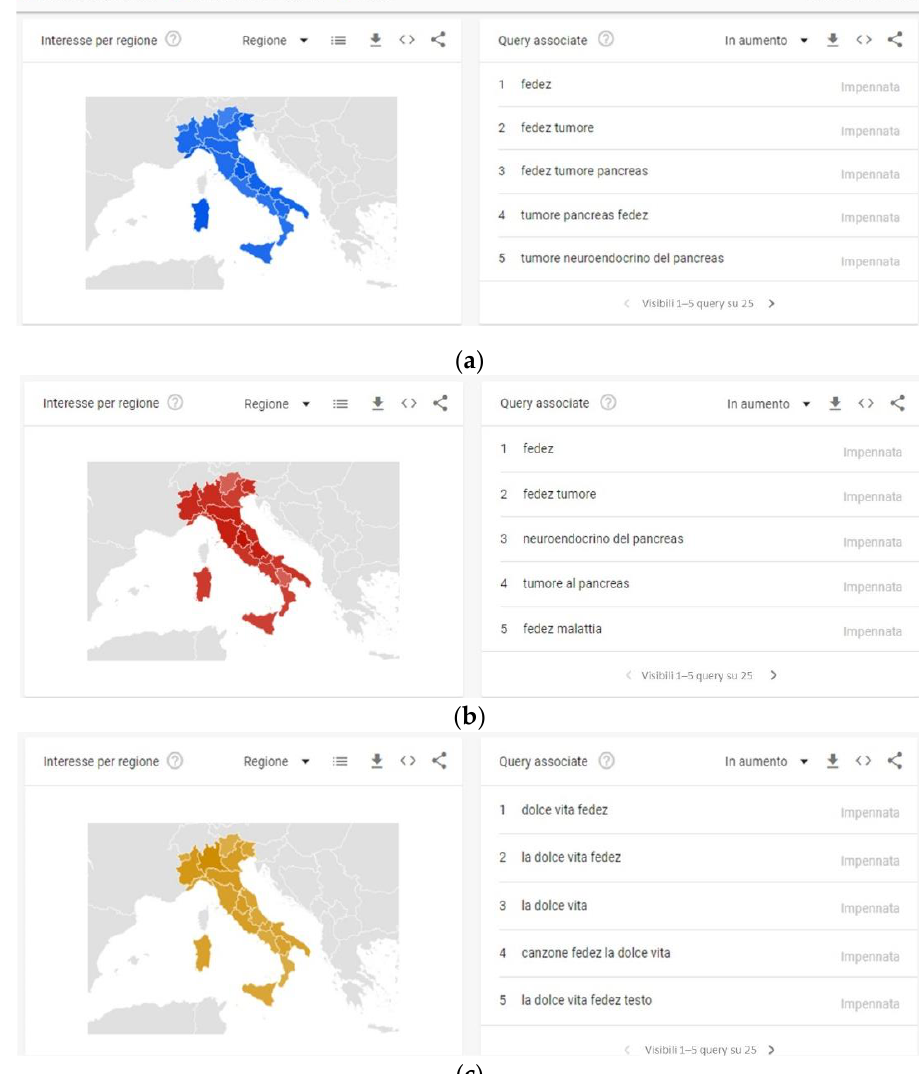
Figure 3. The top five queries on Google Trends connected with the “Fedez” ( a ), “Tumore del pan- creas”; ( b ) pancreatic cancer in English, and “Tumore neuroendocrino”; ( c ) neuroendocrine cancer in English search terms.